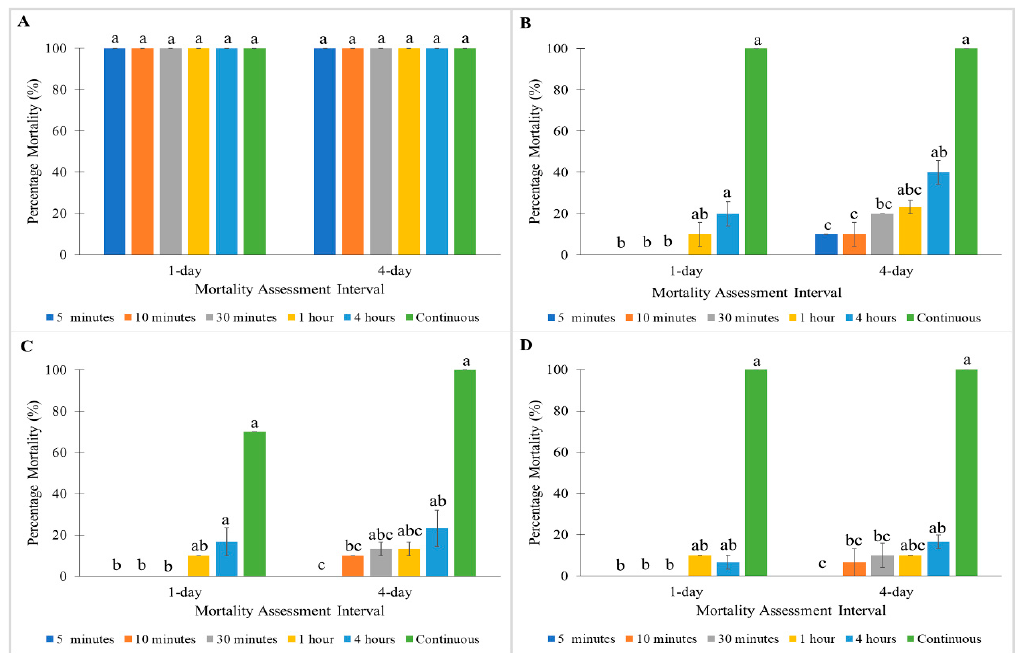
Figure 5. Influence of exposure time on Sumithion on percentage mortalities of a susceptible C. lectularius strain and three C. hemipterus strains at 1 and 4 days post-treatment. ( A ) Monheim, ( B ) Madam Mo, ( C ) Tanjong Tokong, ( D ) Green Lane strains. Bars with di ff erent letters are significantly di ff erent (Kruskal–Wallis test, p <